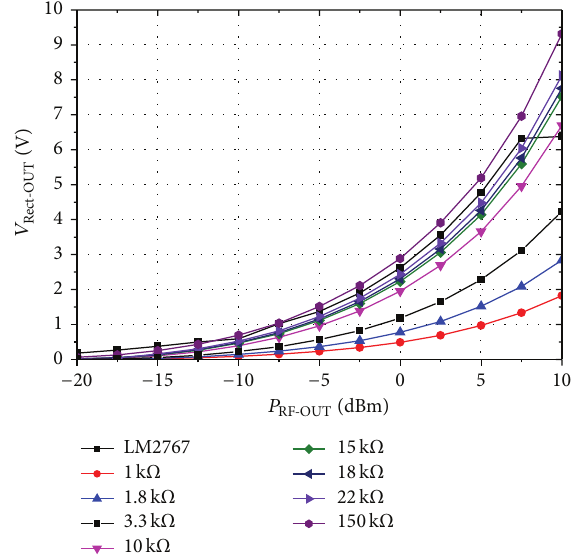
Figure 13: 𝑉 as function of 𝑃 for different resistive Rect-OUT RF-OUT loads are compared with the one obtained when the rectifier is connected with the boost circuit (see Figure